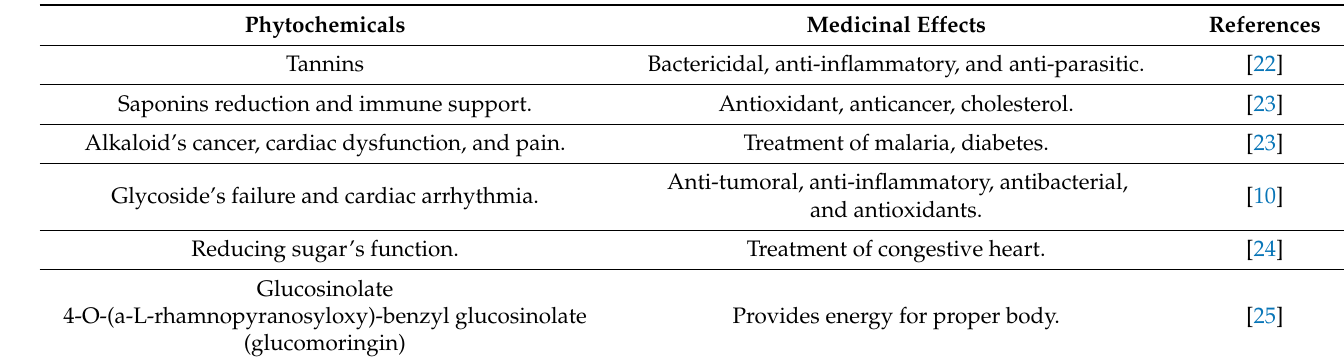
Table 1. Various beneficial phytochemicals of M. oleifera and their medicinal effect.